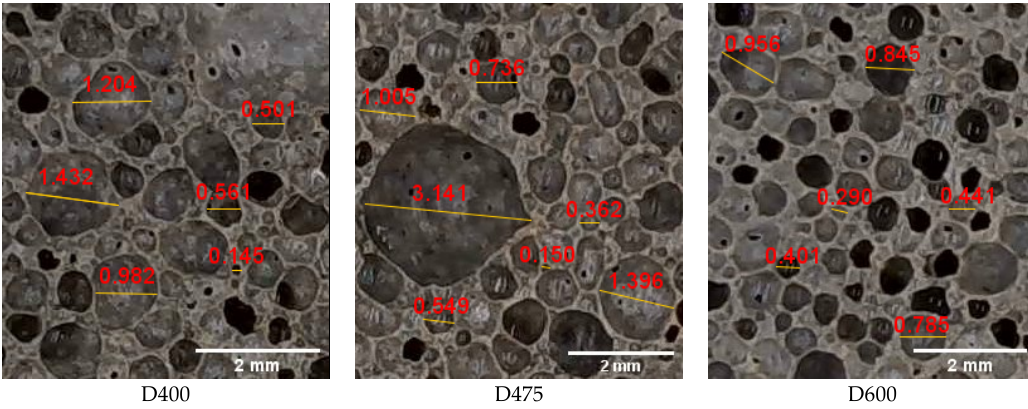
Figure 4. Images of specimens captured by IHDCS.